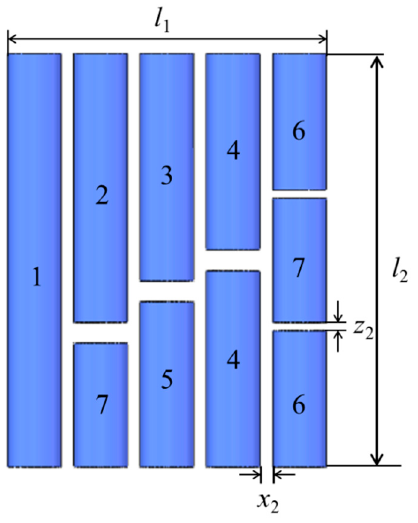
Figure 5. The scheme of the MA cluster acoustic metamaterial structure.